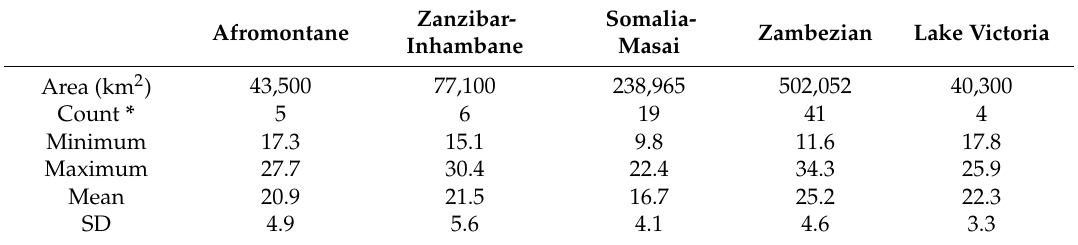
Table 5. Estimates of average AGB (t ha − 1 ) by White ecoregion. *, Refers to the number of RapidEye sites in each